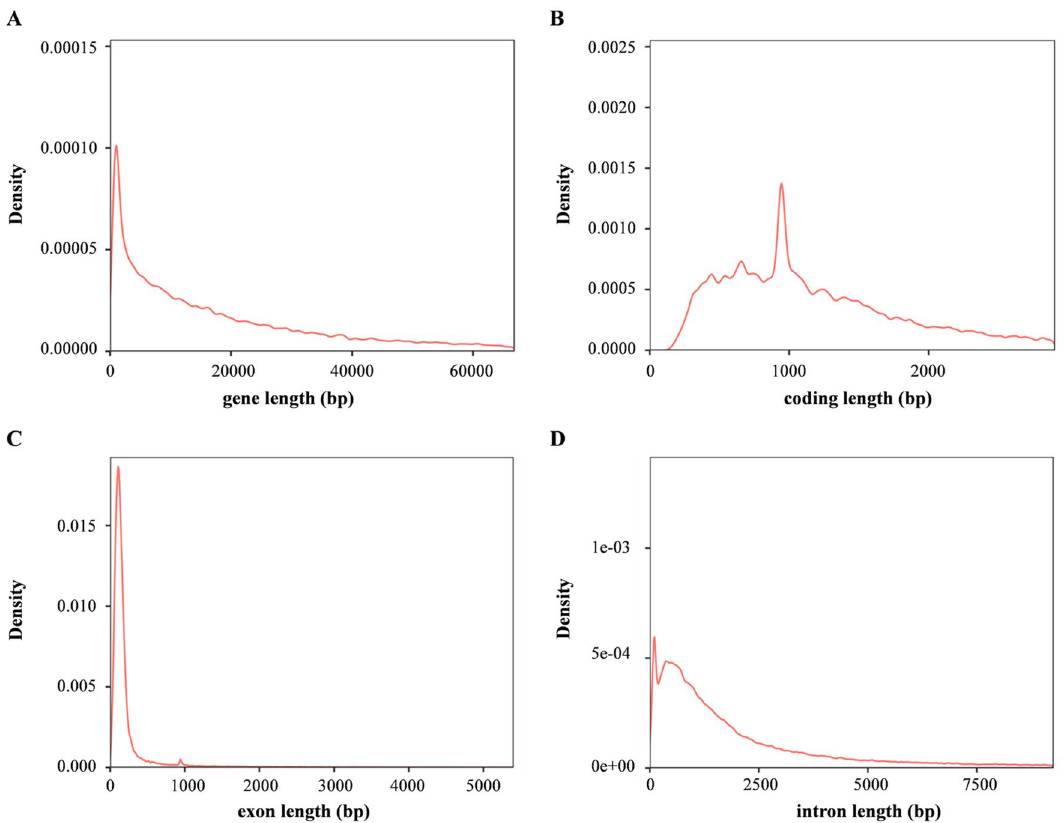
Figure 3. Length distribution of genes ( A ), coding sequences ( B ), exons ( C ) and introns ( D ) in M. mutica